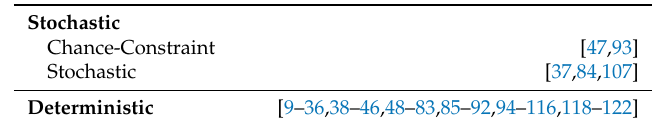
Table 3. Studies by Uncertainty